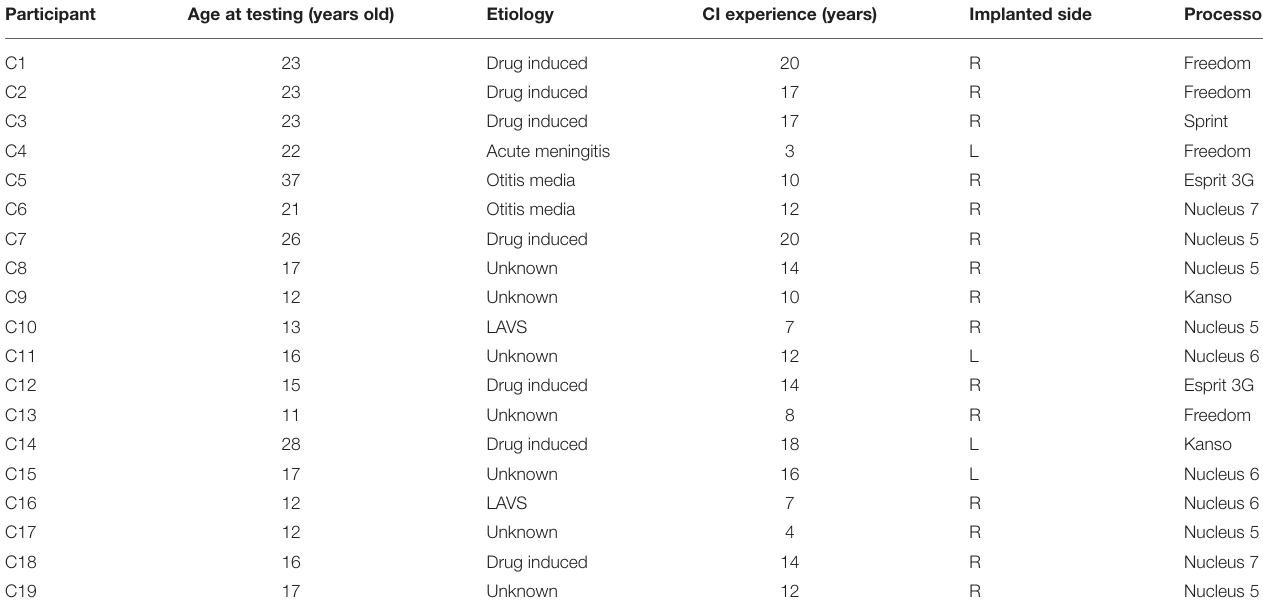
TABLE 3 | The individual subject information for speech recognition evaluation. Participant Age at testing (years old) Etiology Implanted side